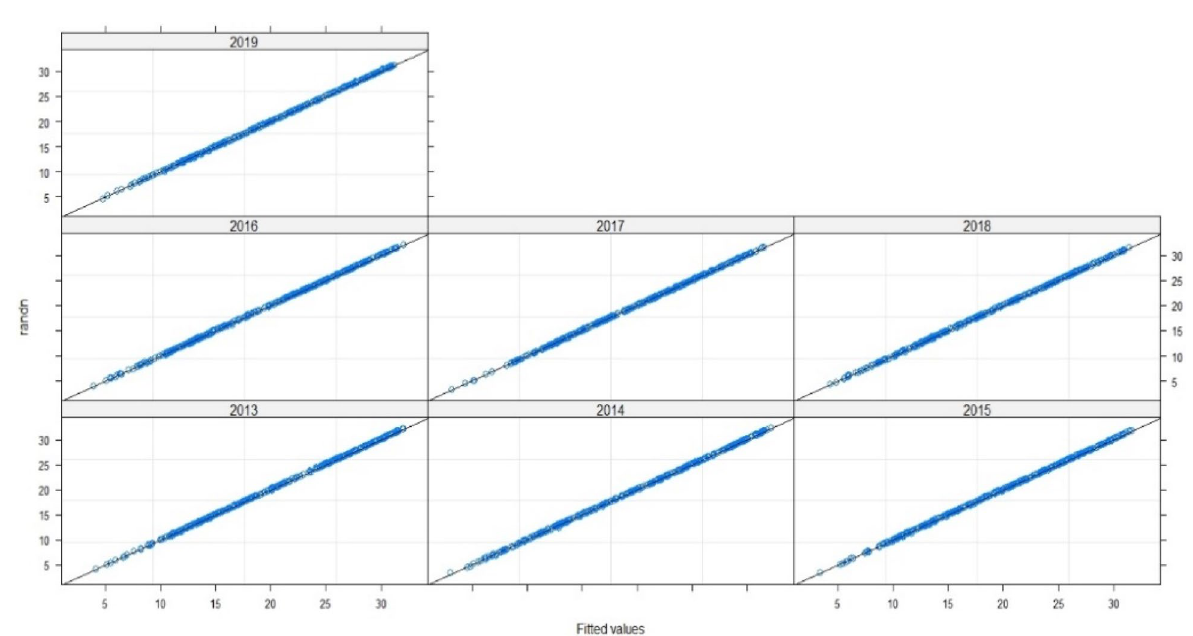
Figure 7. Radiation in terms of the adjusted